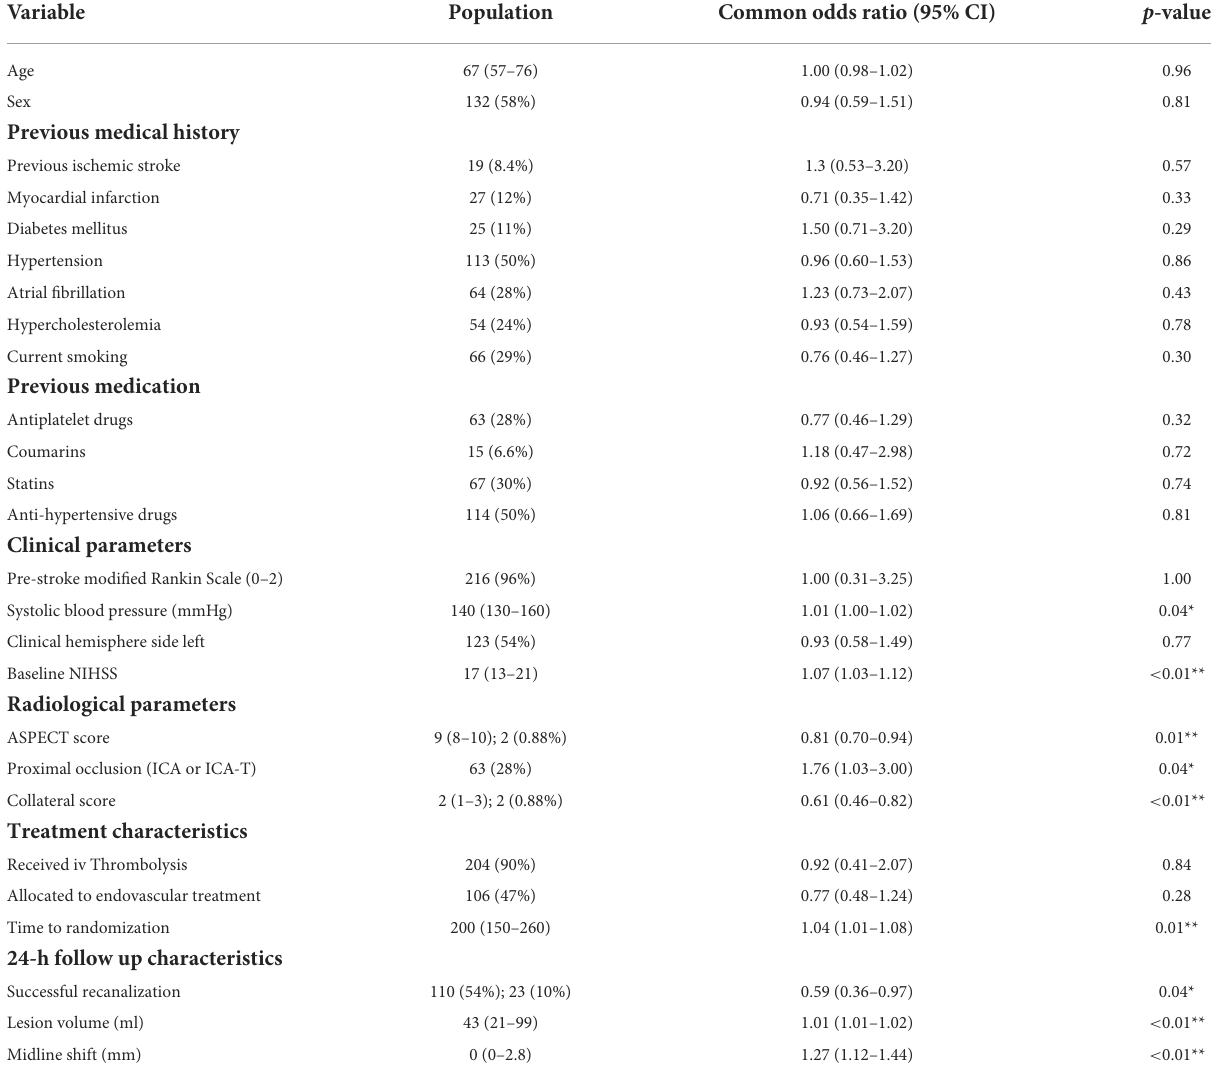
TABLE 1 Baseline, radiological and treatment characteristics of the study population and univariable ordinal regression of these characteristics with subacute lesion evolution.